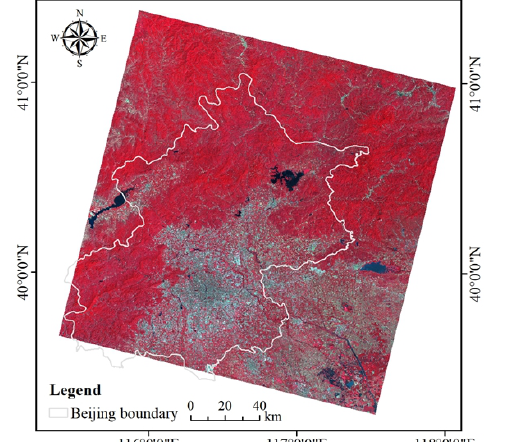
Figure 1. Research area — Beijing, China.